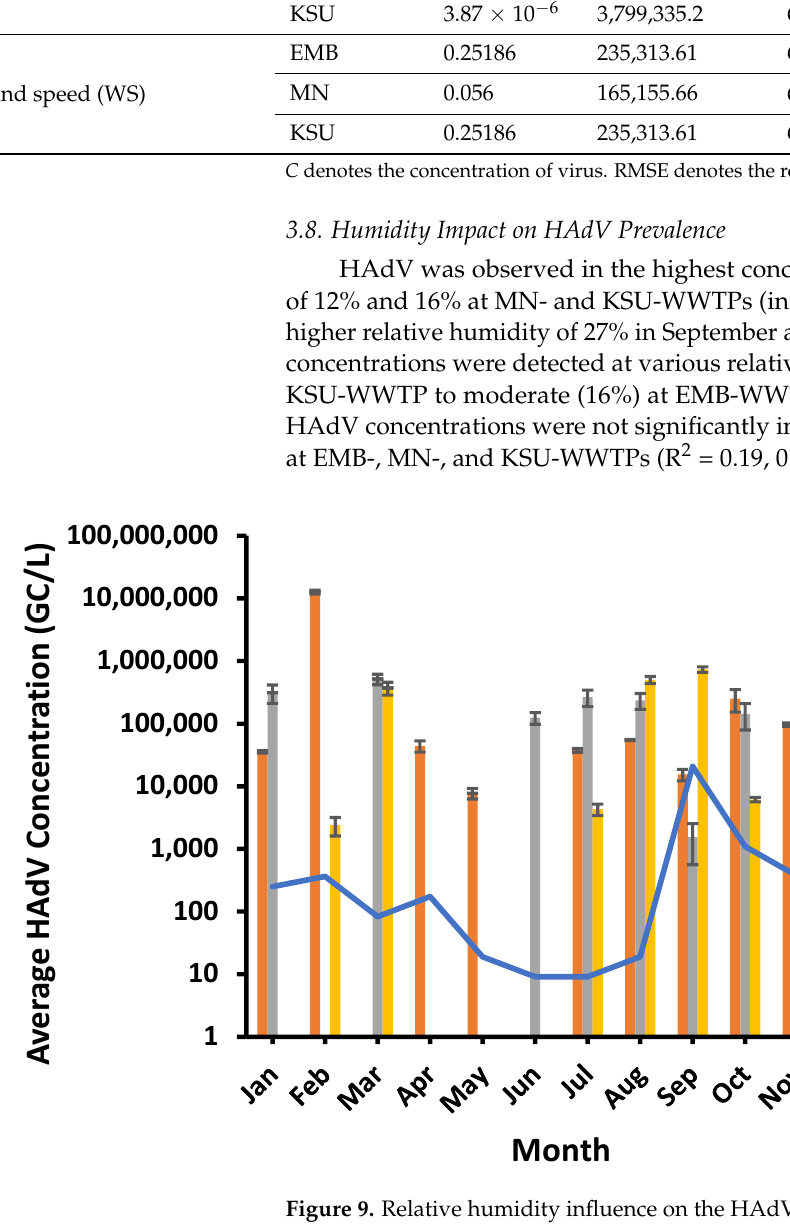
Figure 9. Relative humidity influence on the HAdV concentration .